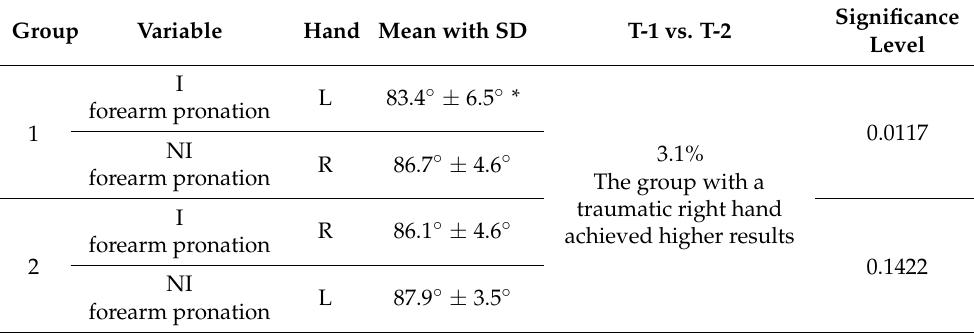
Table 6. Comparison of results for forearm pronation.